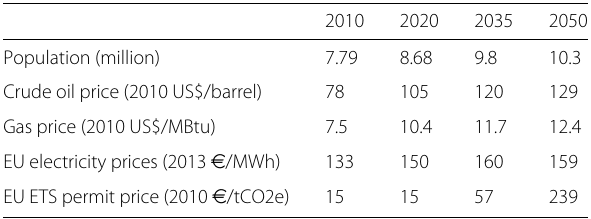
Table 2 Time trends of exogenous parameters facing the Swiss